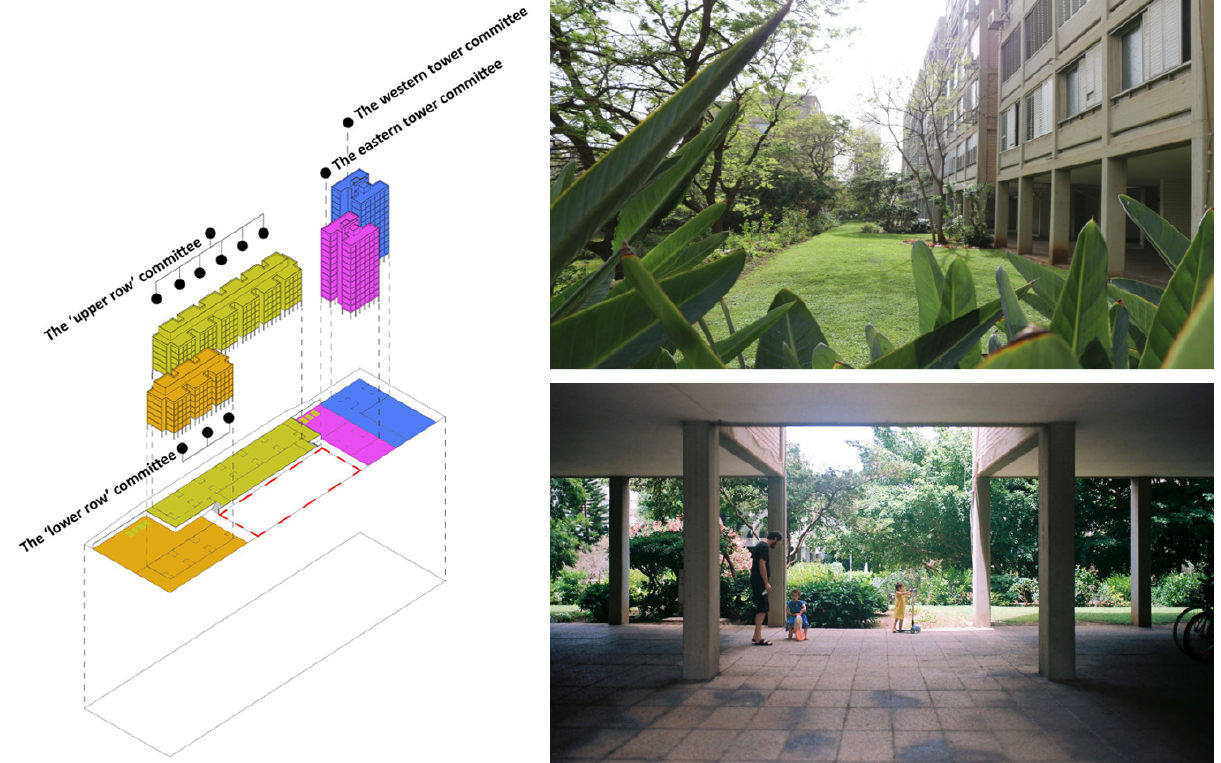
Figure 9. Left: Diagram showing the organizational structure of the Be’eri estate’s community. The different colors mark the part of the common space for which each of the four houses is responsible. The red line shows the central park that the tenants have taken out of the equation. Right: The series of gardens at the foot of the buildings provides spaces for children and communal events. Sources: Photos courtesy of Ali Hasan, 2018, and Guy Margolin,